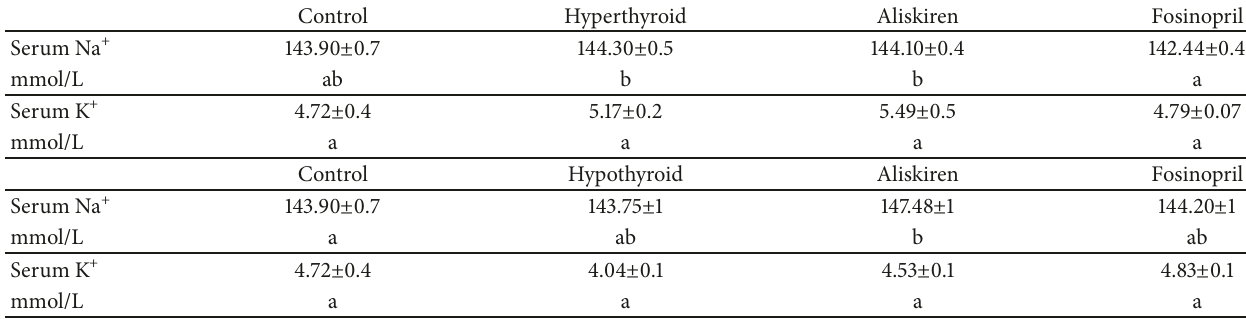
Table 10: Levels of serum Na + and K + in hyperthyroid, hypothyroid, Aliskiren, and Fosinopril